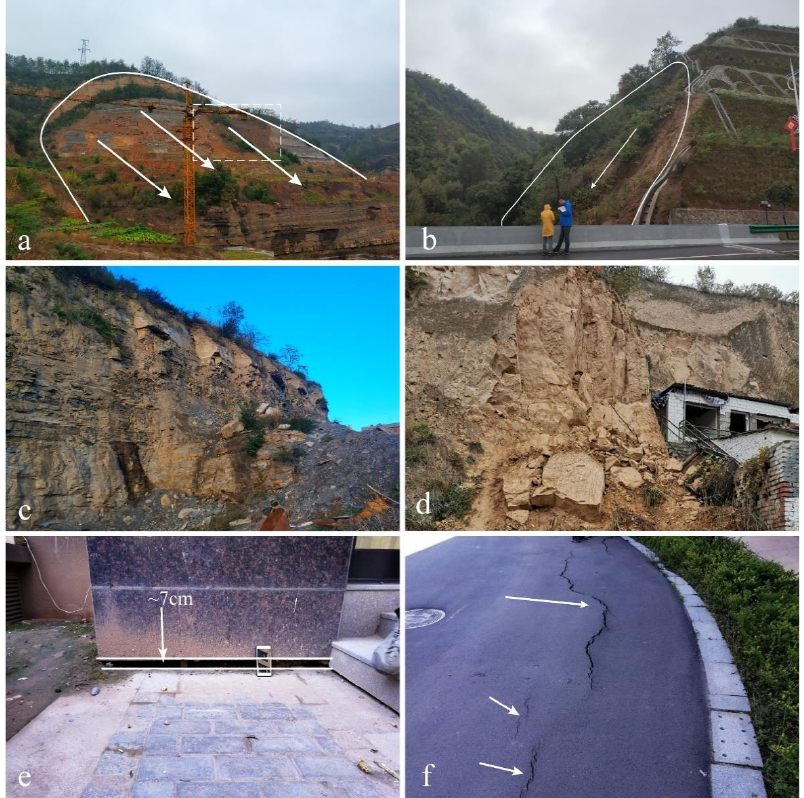
Figure 6. Examples of geohazard types mapped in the study area: ( a ) loess – bedrock interface landslide; ( b ) loess landslide; ( c ) soil–bedrock unstable slope; ( d ) soil unstable slope; and ( e , f ) cracks and damages in the ground and buildings due to land subsidence. Arrows indicate the direction of the slide and the location of the cracks. Table 3. Types and characteristics of landslides and unstable slopes. L and U represent landslides and unstable slopes,